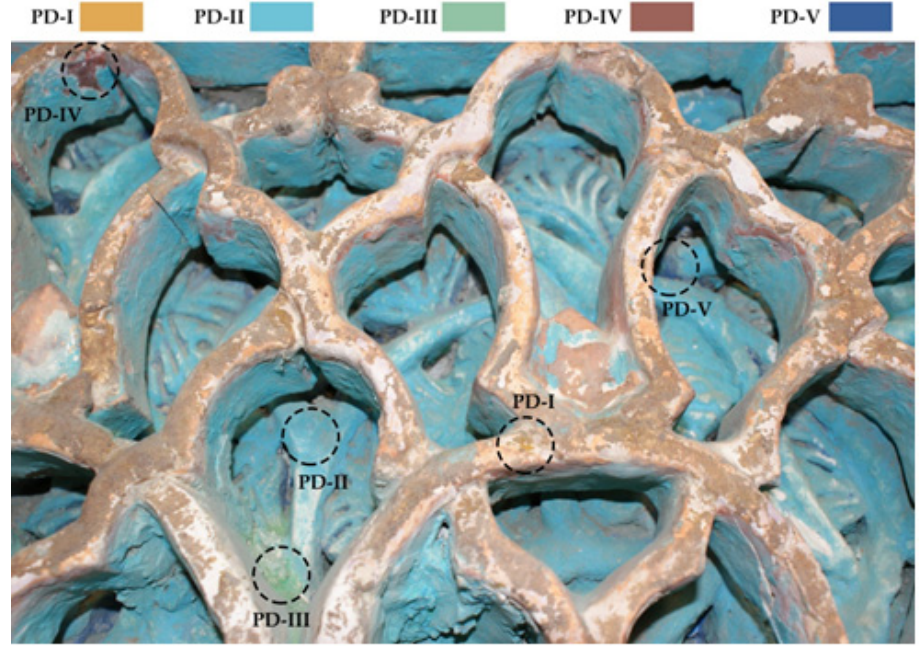
Figure 4. Polychromies present in the spandrel: golden layer (PD-I), emerald green (PD-II), artificial ultramarine blue (PD-III), earth red (PD-IV), and azurite (PD-V).